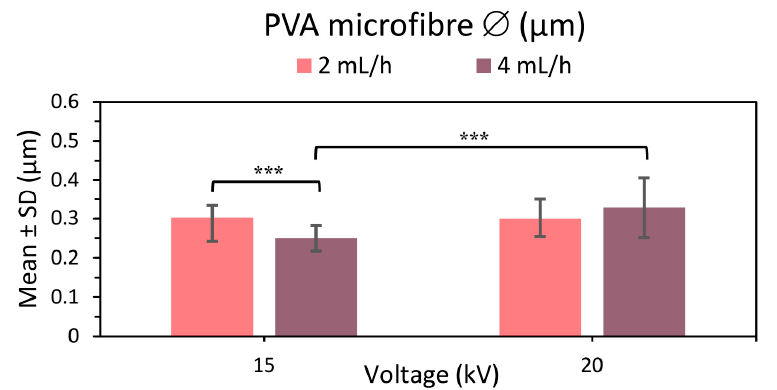
Figure 5. Mean and standard deviation of the diameters of 21% PVA micro fi bers manufactured at 2 and 4 mL/h and applying 15 and 20 kV, at (***) p < 0.001 statistically signi fi cant di ff erence.